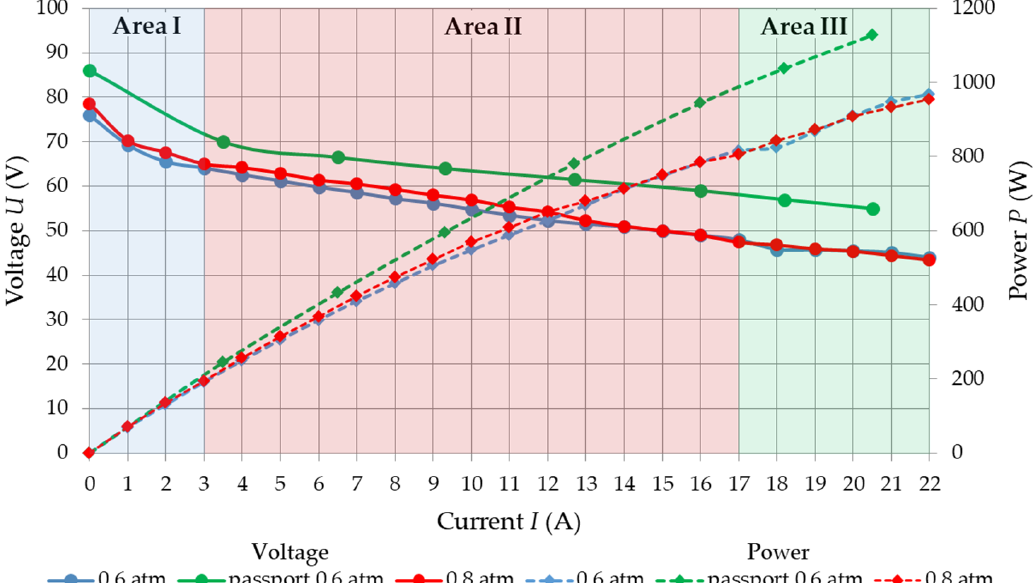
Figure 6. Comparison of the nominal and measured V–I (solid line) and power (dotted) characteristics of PEMFC: green color—nominal at p = 0.6 atm; blue color—measured at p = 0.6 atm; red color—measured at p = 0.8 atm.